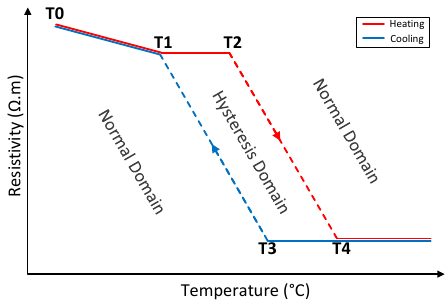
Figure 6. Hysteresis model in the custom simulator.